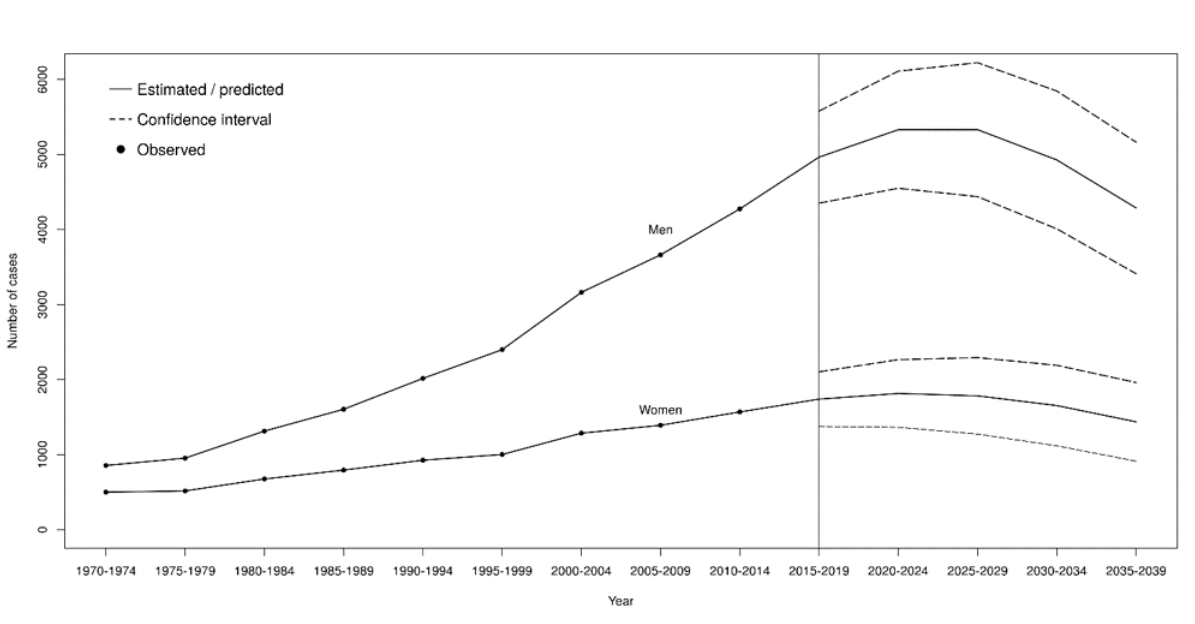
Figure 3. Observed and predicted number of cases of malignant pleural mesothelioma, with 95% predicted intervals. Age–period–cohort model, Italy,